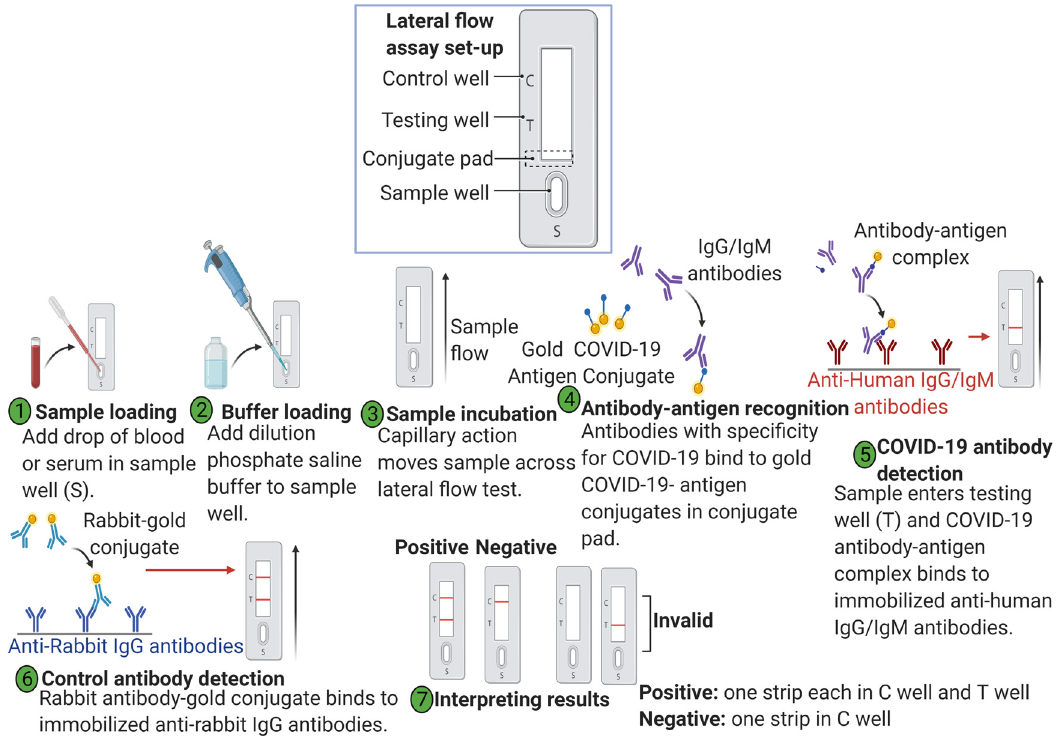
Figure 4: Serological immunoassay of qSARS - CoV - 2 IgG/IgM rapid test for the detection of COVID - 19